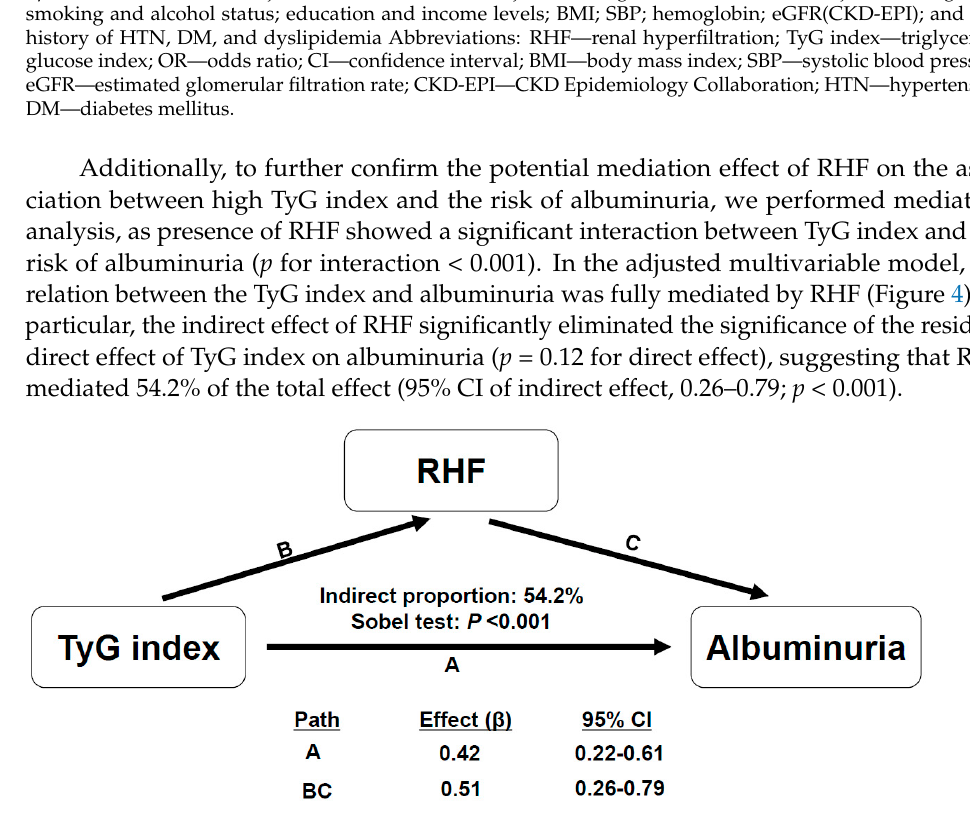
Table 6. Comparison of predictive power for the risk of albuminuria with TyG index with or with- out RHF.